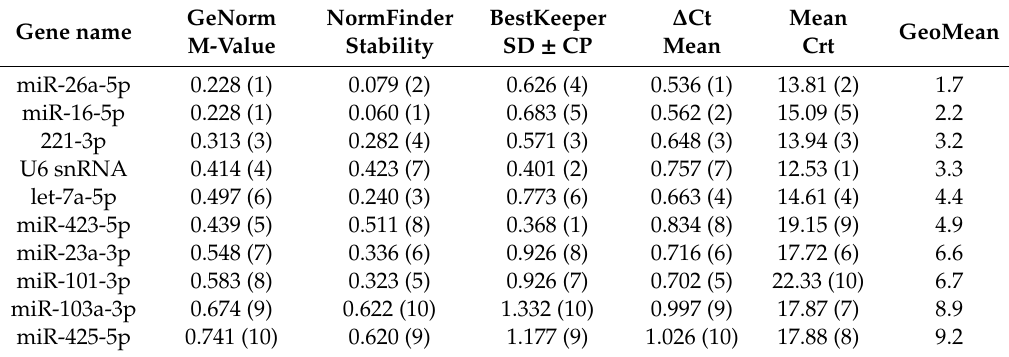
Table 1. Stability levels of candidate